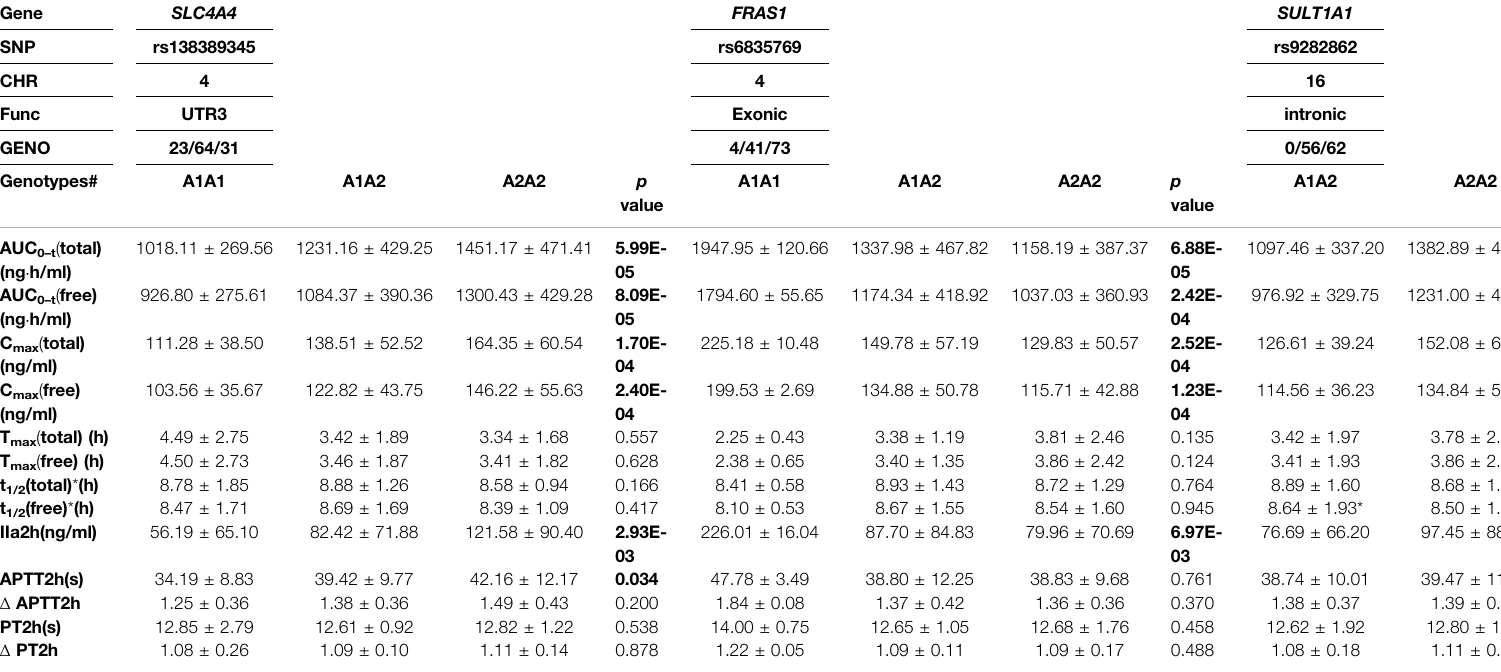
SNP,singlenucleotidepolymorphism;CHR,chromosome;Func,theregionofthegenomewherethemutationis;UTR,untranslatedregions;A1,minorallele;A2,non-minorallele,GENO,Numberofeachgenotype(A1A1/A1A2/A2A2);AUC, areaundertheplasmaconcentration-timecurve;AUC 0- t ,areaundertheplasmaconcentration-timecurvefrom0tothelastmeasurabletimepoint;C max ,maximumplasmaconcentration;T max ,timetopeakconcentration;t ½ ,half-life;IIa2h: valueofanti-IIa,at2 hafterdosing;APTT2h,valueofactivatedpartialthromboplastintimeat2 hafterdosing; Δ APTT2h,foldchangeinAPTT,atpost-dose2 htopre-dose0h;PT2h,valueofprothrombintimeat2 hafterdosing; Δ PT2h,fold change in PT, at post-dose 2 h to pre-dose 0 h. The bold values mean p -value <